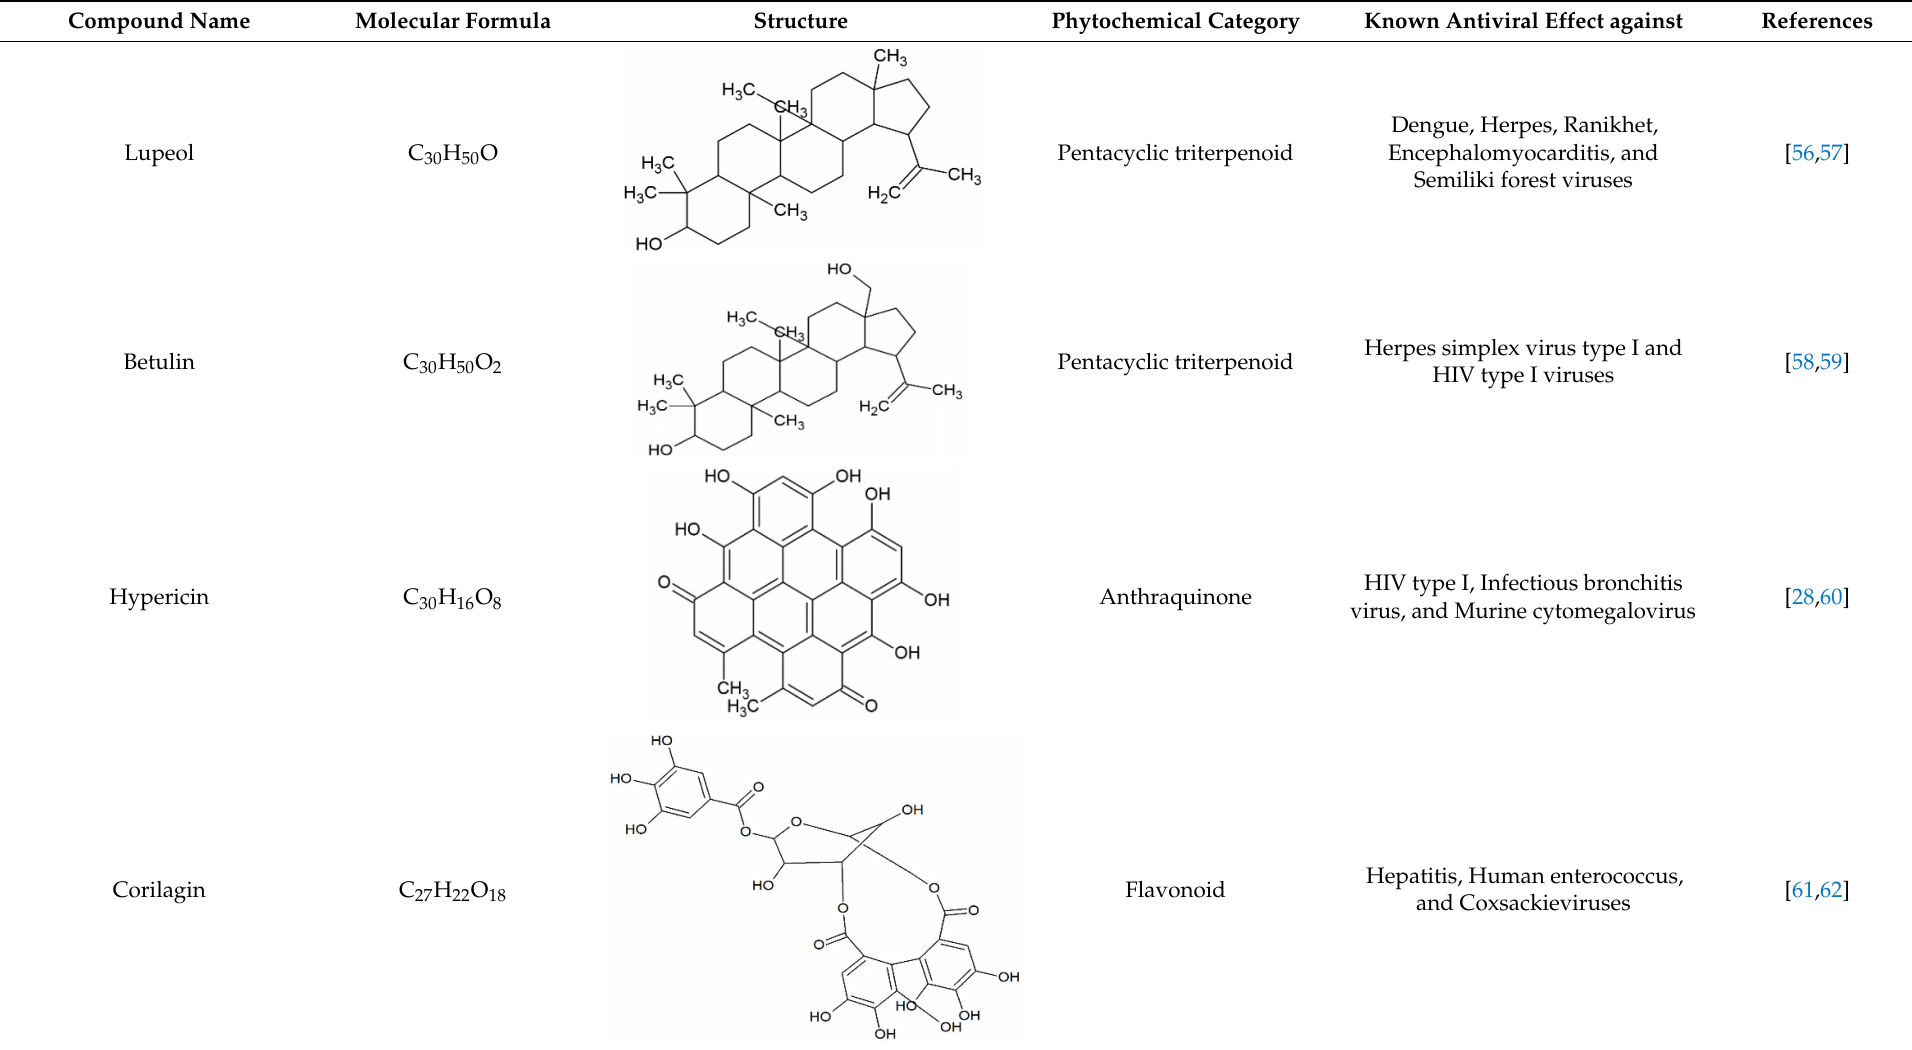
Table 6. Top-ranked phytochemical compounds selected from the virtual screening